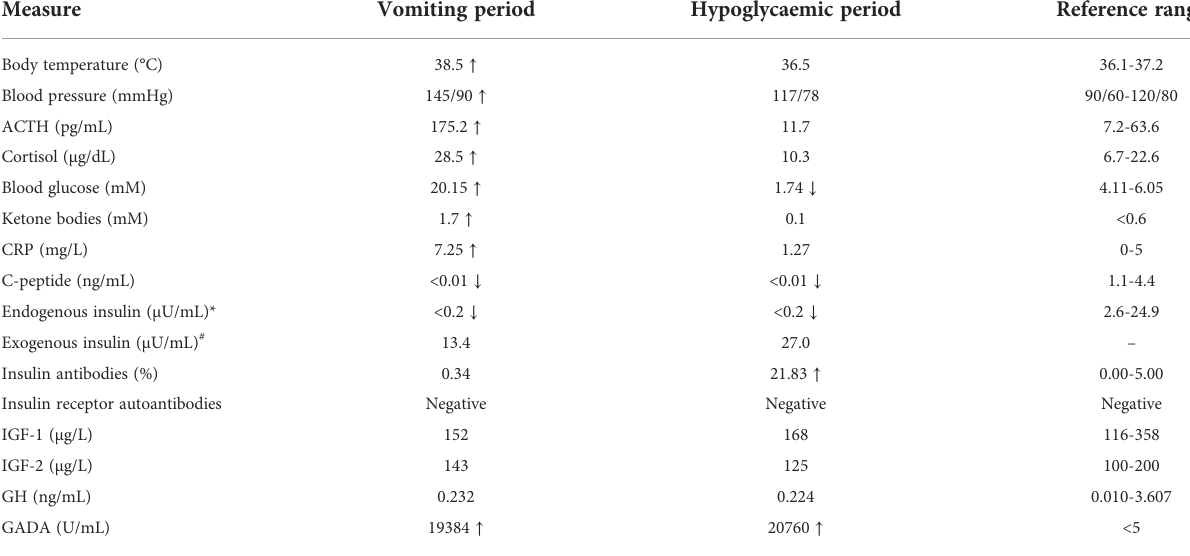
TABLE 1 Laboratory measures for the vomiting period and hypoglycaemic period during one hospital stay.